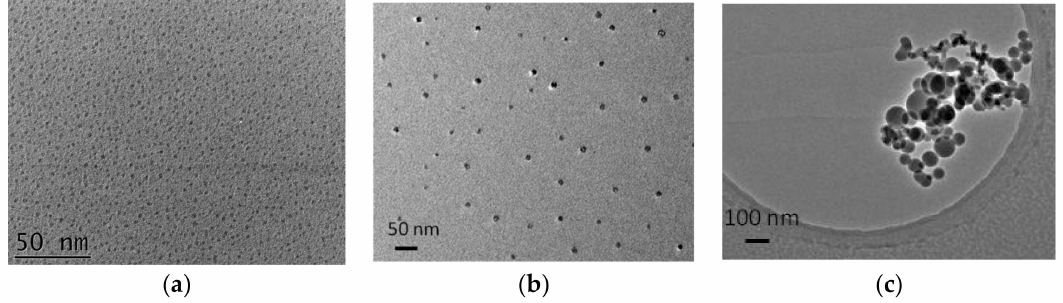
Figure 6. Bright field TEM images of Sample A TiO 2 NPs ( a ) directly after synthesis and ( b ) after the end of the experiment period, and ( c ) of the SiO 2